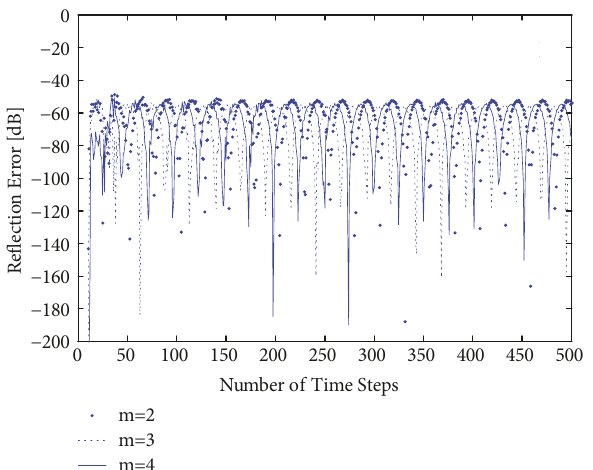
Figure 5: Reflection error as a function of time step for Example II.